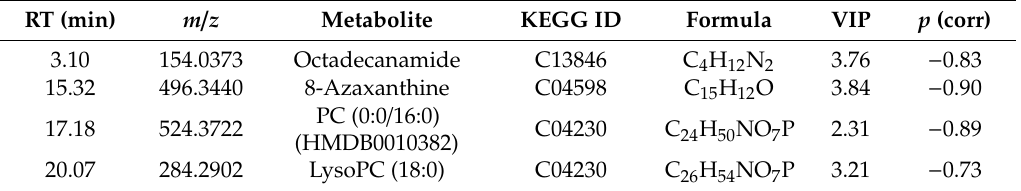
Table 4. Di ff erential identified metabolites for discrimination among control and BA-12 groups based on UPLC–TOF-MS metabolomics. KEGG ID—Kyoto Encyclopedia of Genes and Genomes identifier; PC—phosphatidylcholine.